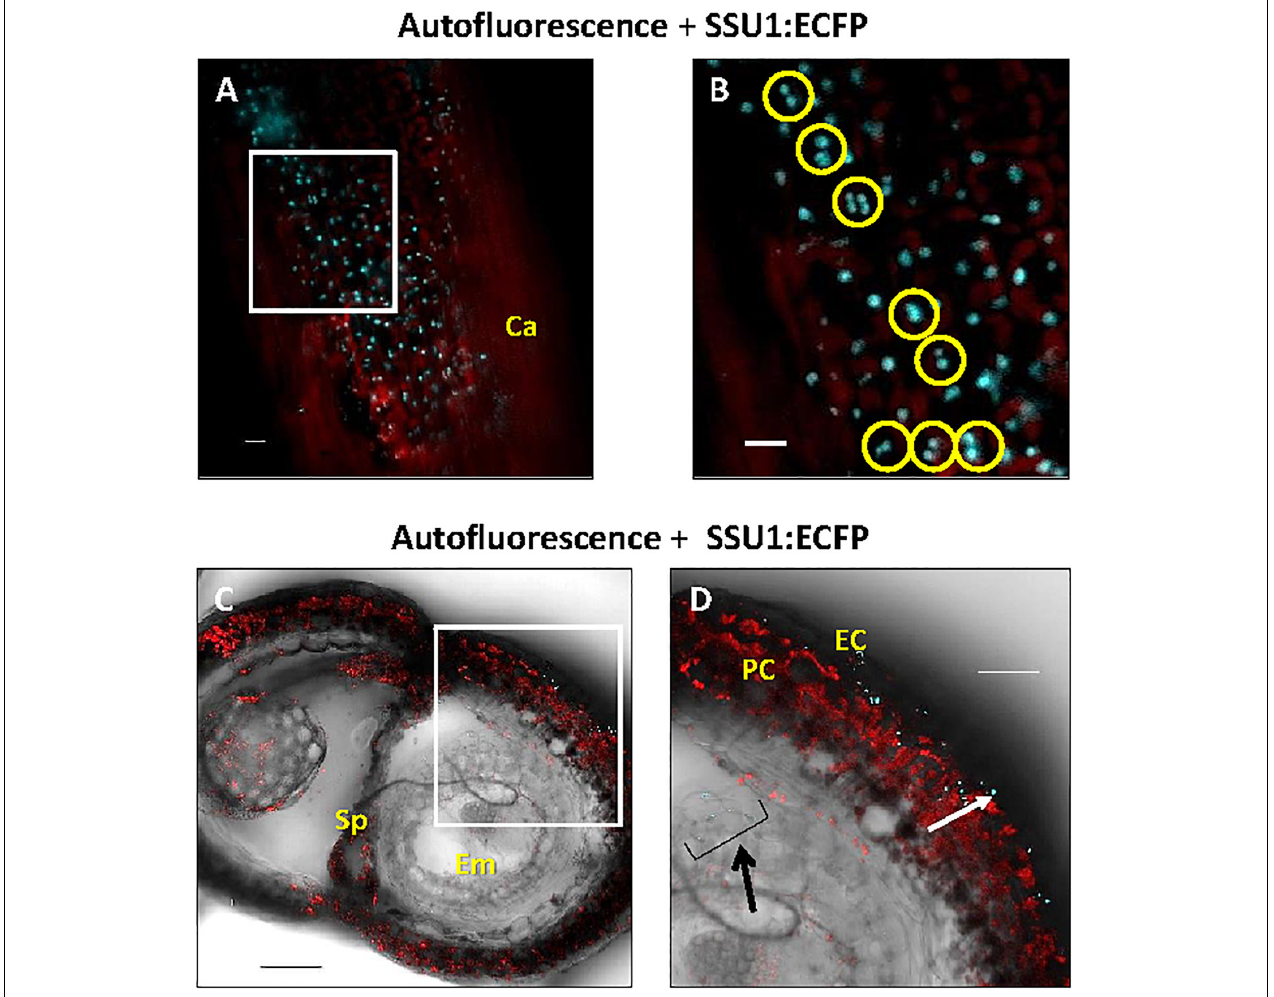
FIGURE 8 | Cellular and subcellular localization of the IPMI SSU1 protein in a premature silique. (A) An overlay of the fluorescence of IPMI SSU1:ECFP (cyan) and the chlorophyll autofluorescence (red) indicates that IPMI SSU1 is located in small sensory plastid-like organelles within cell layers above the chloroplast-containing cells (Ca, carpel). (B) A magnification of a part of the image shown in ( A, white box) highlights the presence of IPMI SSU1 in dividing plastids (yellow circles). (C,D) In a cross section, IPMI SSU1:ECFP fluorescence (cyan) can be seen in small plastids (with a longitudinal diameter of approximately 4–5 µ m) in epidermal cells (EC). In contrast, pericarp cells (PC) contain many chloroplasts as indicated by the chlorophyll fluorescence (red). In addition, IPMI SSU1:ECFP fluorescence is visible in outer cell layers in the developing seed (indicated by a black arrow). Sp, septum; Em, embryo. Scale bars: (A) 100 µ m, (B) 10 µ m and (C,D) 50 µ